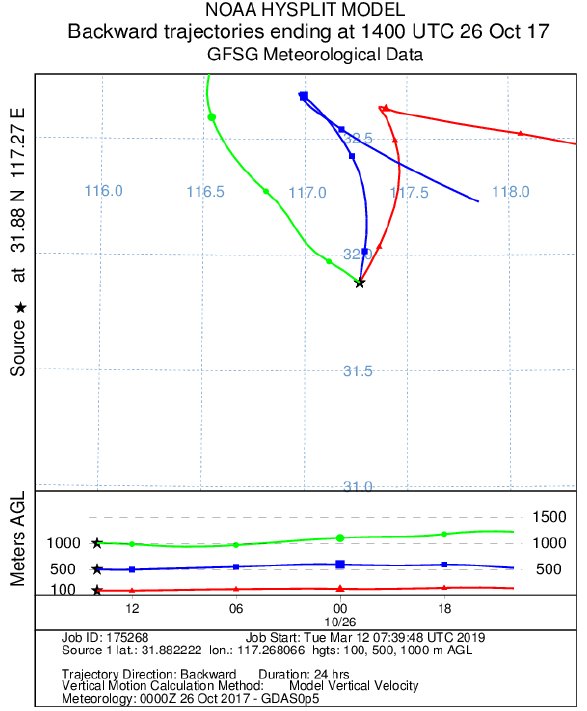
Fig. 7 Hysplit model simulated 24-hours backward trajectories of Hefei ending at 22 pm Universal Time, UTC) on October 26th,